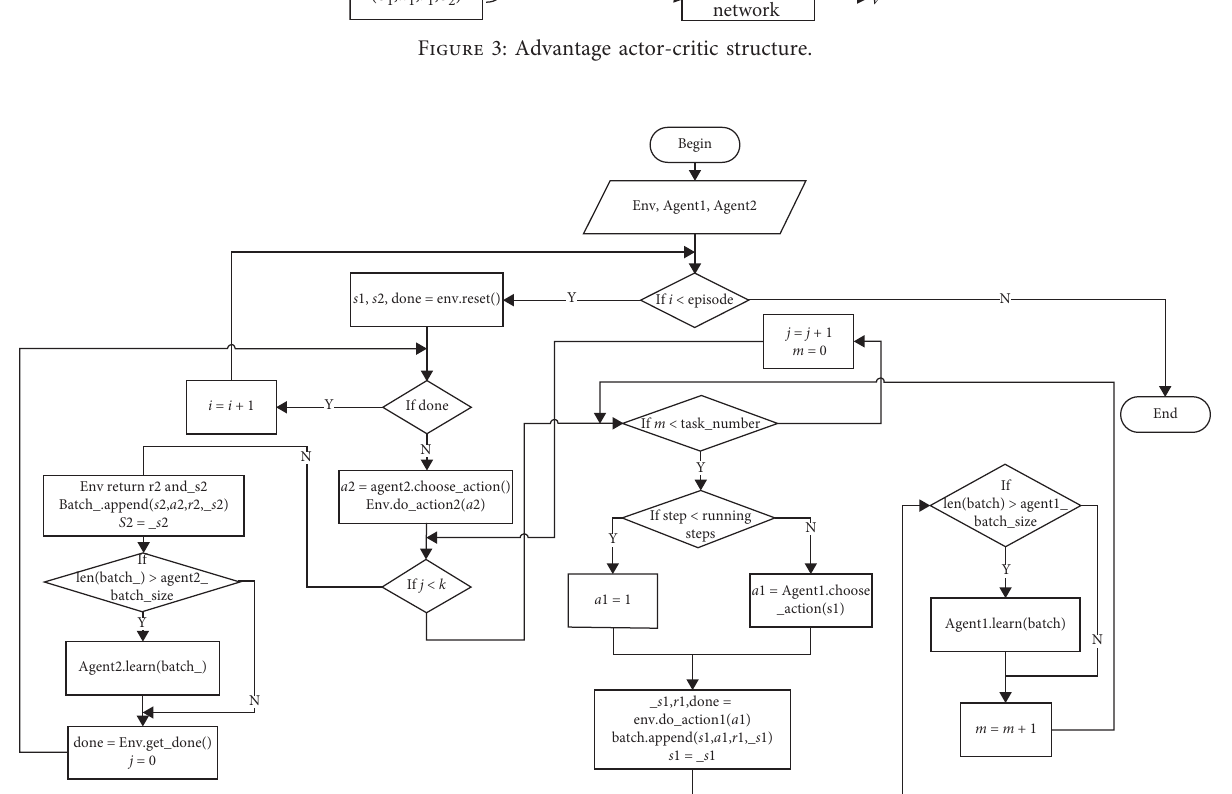
Figure 4: The flowchart of model training process.